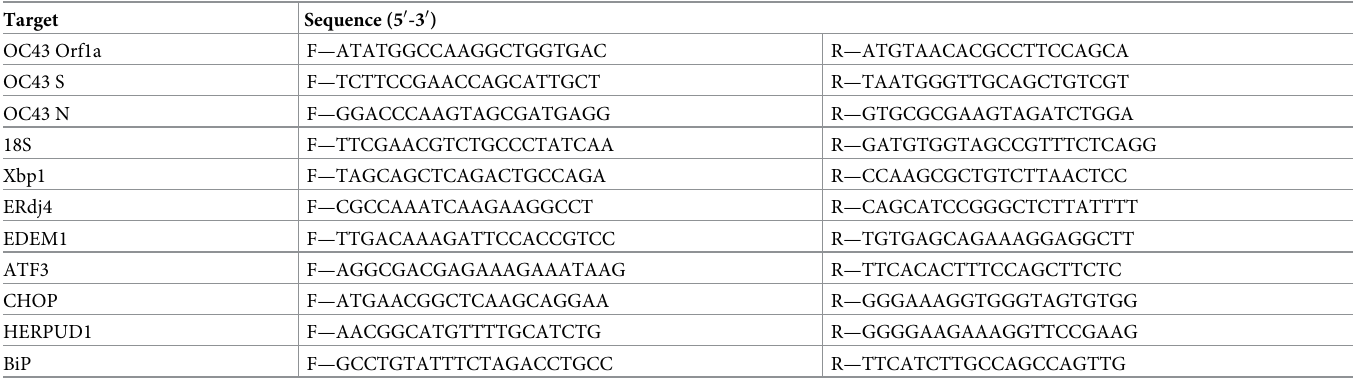
Table 1. Primer sequences for RT-qPCR